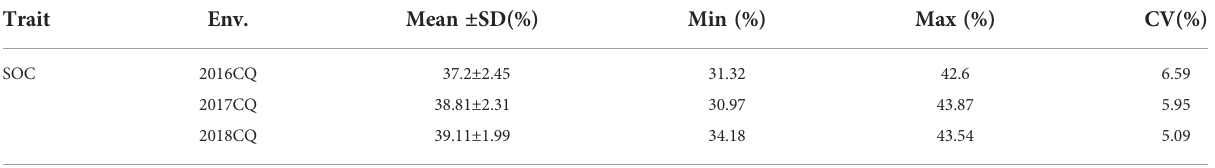
TABLE 1 Phenotypic variation in seed oil content (SOC) in the recombinant inbred line (RIL) population.